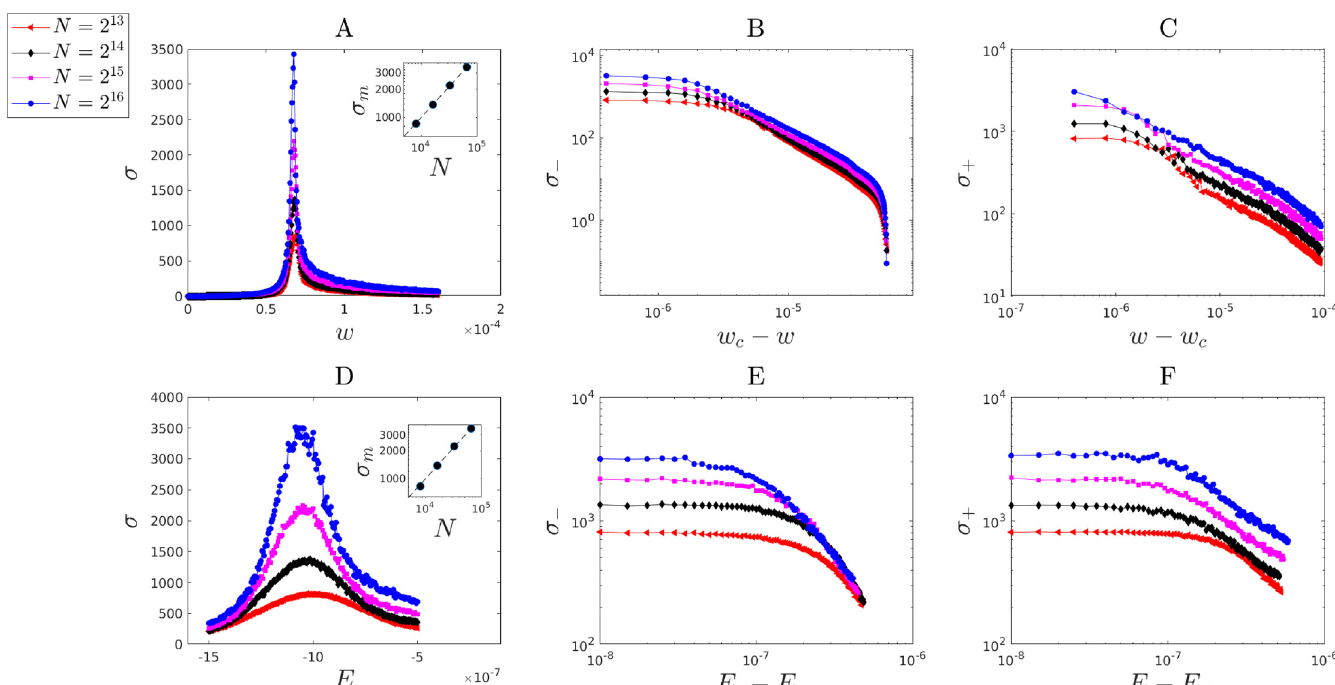
Fig 9. Power-law divergence of stochastic fluctuations in spread size near the critical point. We used finite-size scaling analysis over four different network sizes of 2 13 , 2 14 , 2 15 , 2 16 . A The standard-deviation σ of the fluctuations as a function of w (fixed E = E c ) near the critical point ( w c � 6.7610 − 5 , E c � 1.0010 − 6 ). The inset shows the power-law divergence of σ at its maximum and the corresponding scaling σ * N 0.66(1) . B,C Power-law behavior of σ shown on log-scale for w approaching the critical m point from below with corresponding scaling s � ð w (cid:0) w Þ (cid:0) g 0 and exponent estimated as ^ g 0 ¼ 1 : 63 ð 3 Þ , and from above with corresponding scaling σ + * ( w − w (cid:0) c and exponent estimated as ^ g ¼ 0 : 63 ð 1 Þ , respectively. D The standard-deviation σ of the fluctuations as a function of E (fixed w = w c ) near the critical point. The inset shows the power-law divergence of σ at its maximum and the corresponding scaling σ m * N 0.68(1) . G,H Power-law behavior of σ ( E ) shown on log-scale for E approaching the critical point from below with corresponding scaling s � ð E (cid:0) E Þ (cid:0) a 0 and exponent estimated as ^ a 0 ¼ 1 : 4 ð 1 Þ , and from above with corresponding (cid:0) c scaling σ + * ( E − E ) − α and exponent estimated as ^ a ¼ 0 : 87 ð 5 Þ c